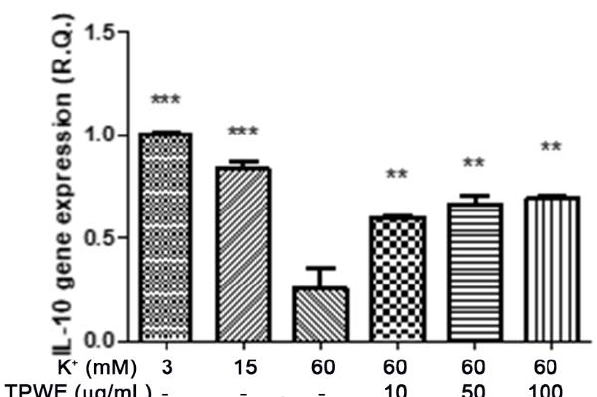
Figure 5. The stimulating effect induced by Tanacetum parthenium water extract (TPWE: 10–100 µg/mL) on interleukin-10 (IL-10) gene expression (R.Q. = relative quantification) in isolated cortexes challenged with K + 60 mM. ANOVA, p < 0.0001; ** p < 0.01, *** p < 0.001 vs. the K + 60 mM group.